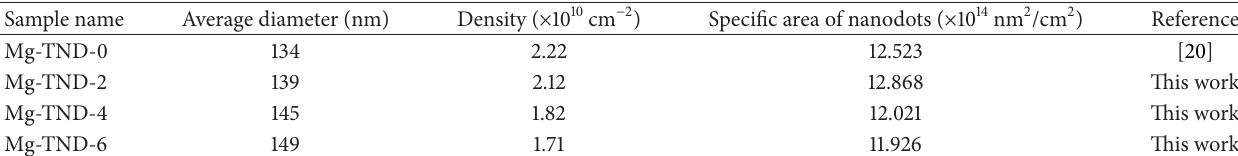
nanodots with various Mg doped concentrations. 2